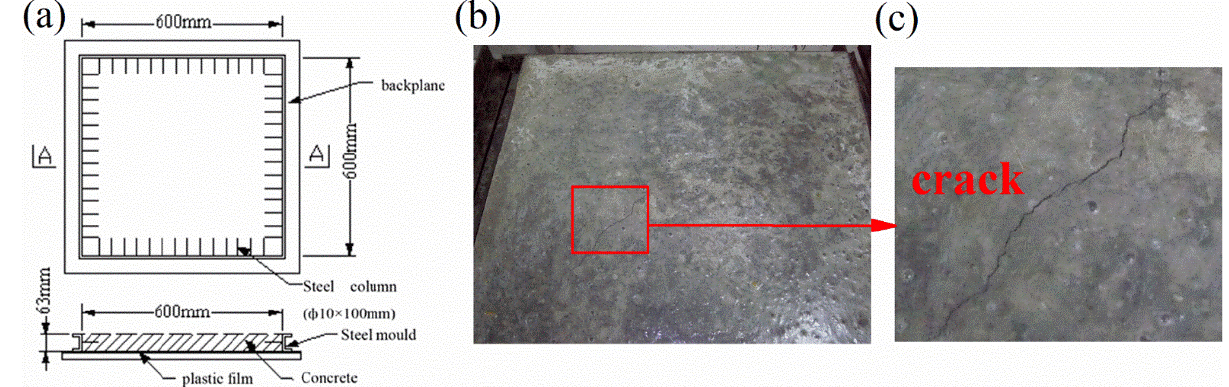
Figure 1. The illustration of the slab test: ( a ) the steel mold, ( b ) specimen and ( c ) crack.